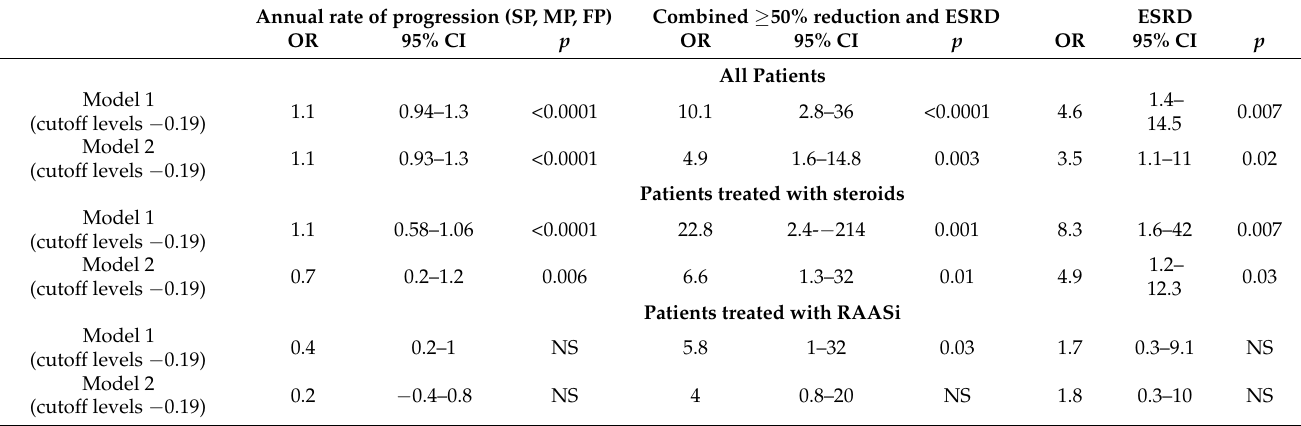
Table 5. Cut-off levels in both Models 1 and 2 had significant impact in renal function outcome, as this was defined by the primary endpoint of slow, moderate, and fast progression, and secondary endpoints of ESRD and combined ≥ 50% reduction in eGFR and